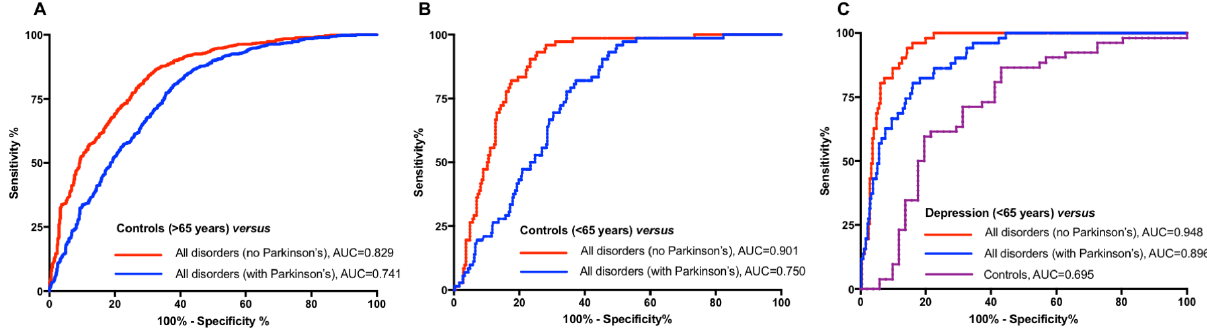
Fig. 4 The diagnsotic accuracy of plasma NfL in identifying neurodegenerative disorders from controls (young/old) and depression. The performance of plasma neuro fi lament light (NfL) to identify neurodegenerative disorders from controls (CU and SCD) > 65 years of age ( A ), controls (CU and SCD) < 65 years of age ( B ), and depression ( C